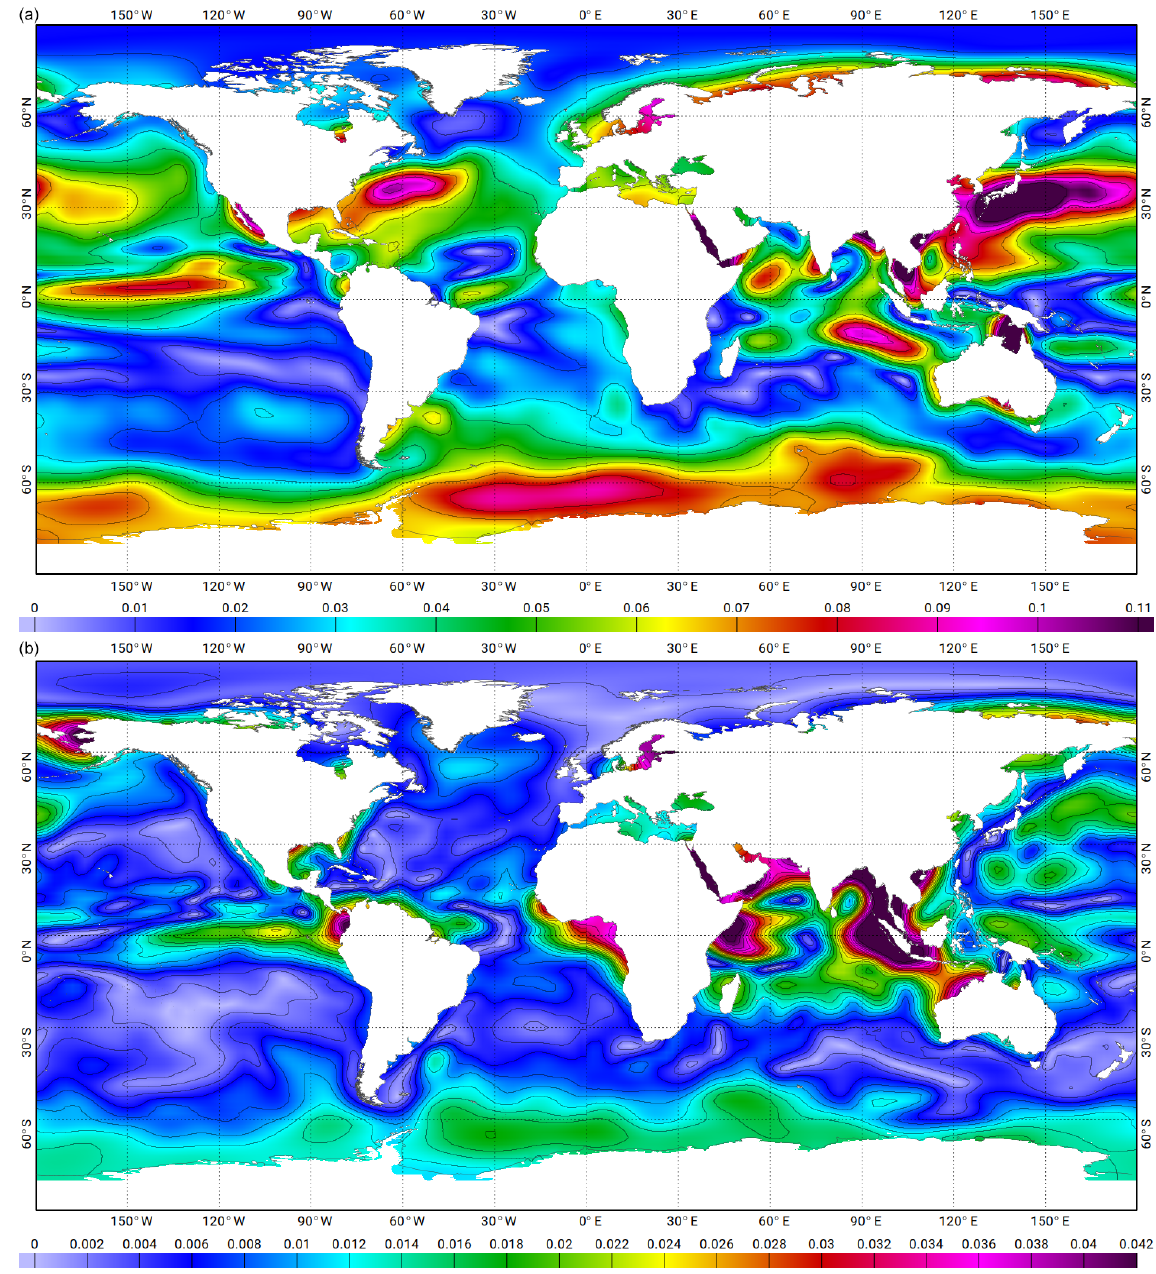
Figure 4. Maps of amplitude in metres of Sa (a) and Ssa (b) ocean signals estimated from GLORYS2v1 reanalysis. GLORYS2v1 products are free of atmospheric surface pressure effects (i.e. they are not taken into account in the NEMO model forcing and are corrected for in the assimilated SSH data). Consequently, they are comparable to IB-corrected sea level (at Sa and Ssa frequencies) in altimetry and tide gauge